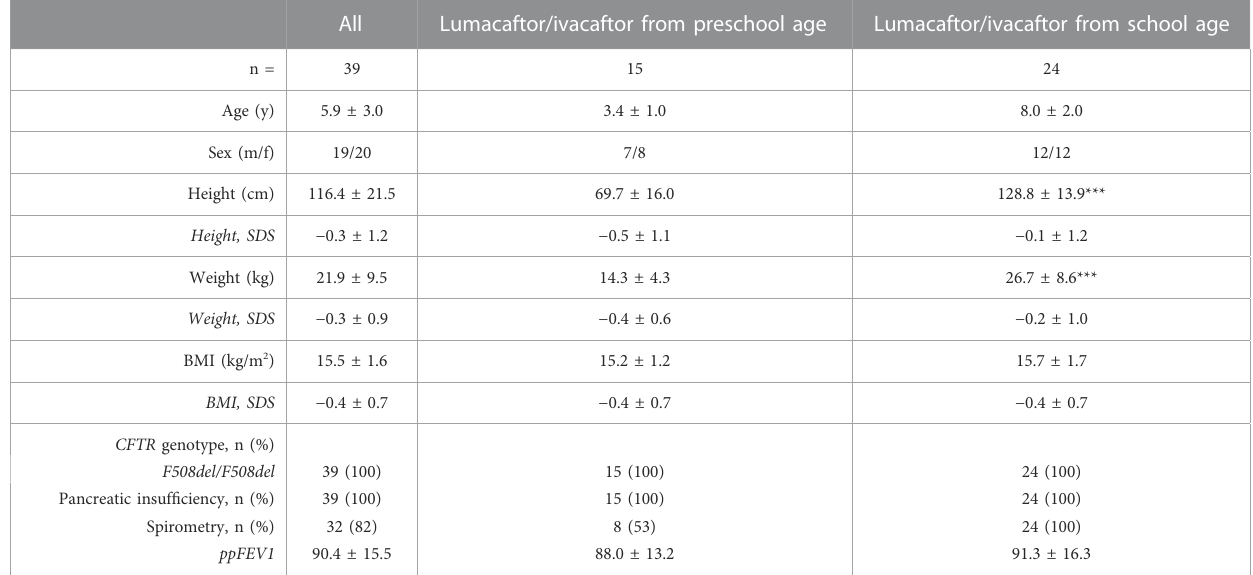
TABLE 1 Patient baseline characteristics. Data presented as mean ± standard deviation, and absolute and relative numbers, respectively. BMI, body mass index, CFTR, cystic fi brosis transmembrane conductance regulator , ppFEV1, percent predicted forced expiratory volume in 1 s, SDS, standard deviation score. *** p < 0.001 vs. lumacaftor/ivacaftor from preschool